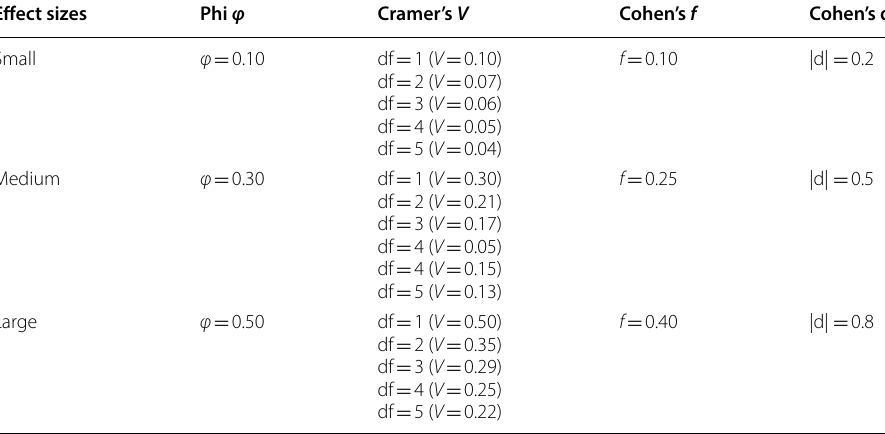
df for Cramer’s V it is referred to as DF* (Cohen